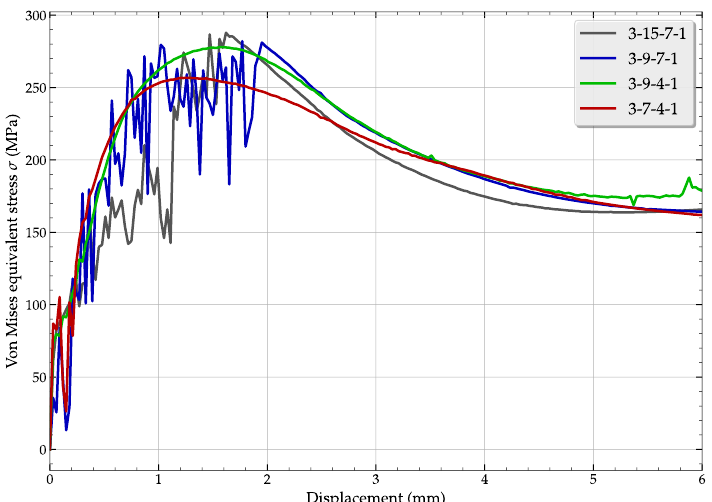
Figure 11. Evolution of the equivalent von Mises stress σ of the specimen during the compression process using the four ANN flow laws.